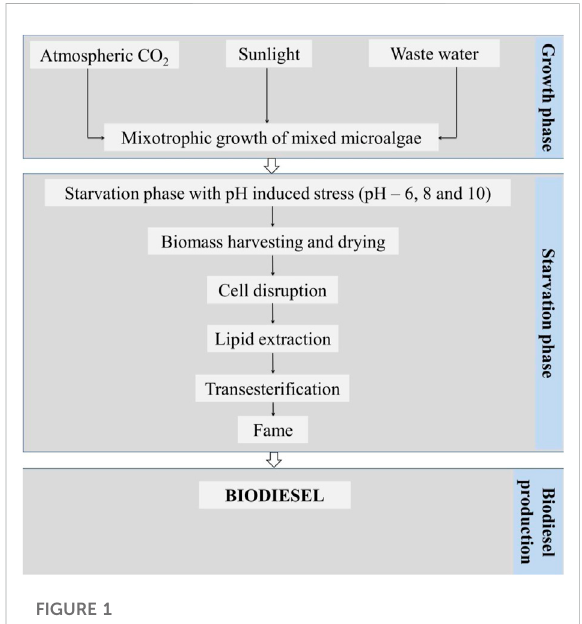
FIGURE 1 Schematic representation of the experimental